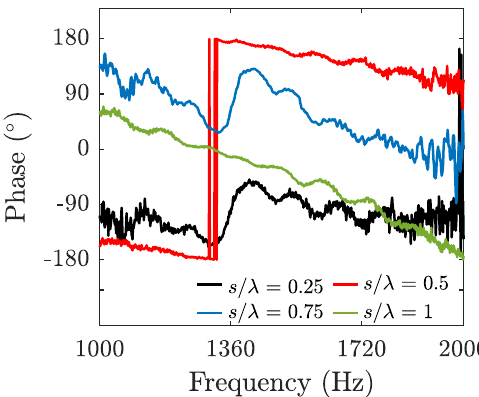
Figure 15. Phase of the pressure signal from M2 relative to M1 for spacing configurations of s / λ = 0.25,0.5, 0.75 and s / λ =